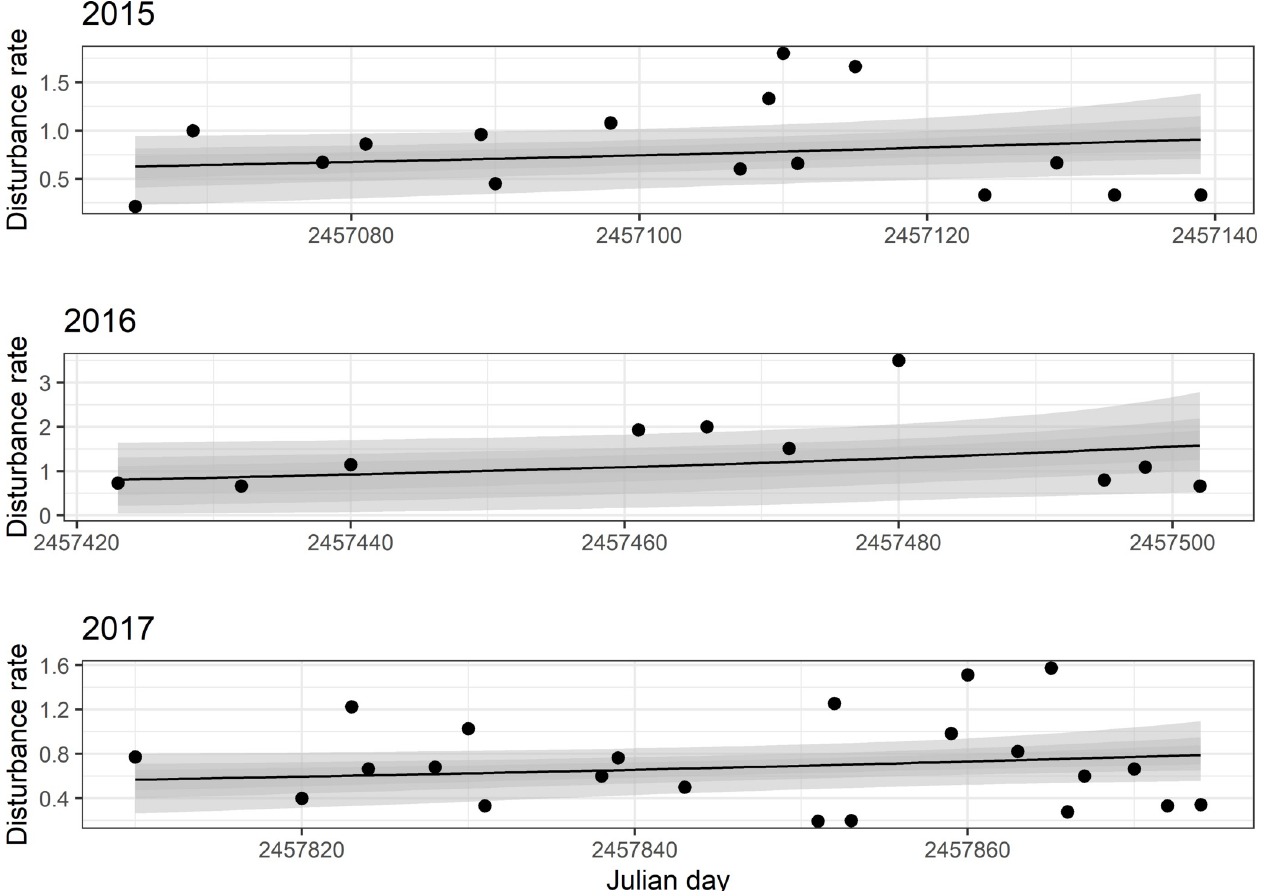
Fig 2. Bayesian linear regressions of disturbance rates (number of disturbance events/h) for the sampling periods undertaken in 2015, 2016, and 2017. Shaded areas correspond to 95% Bayesian credible intervals.